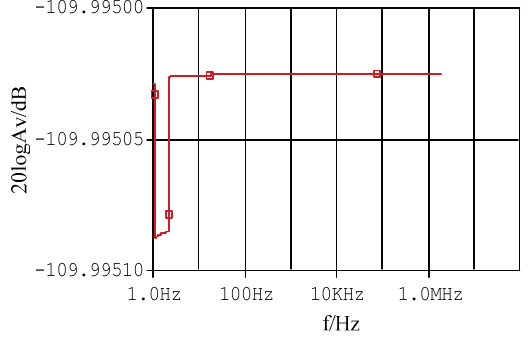
Figure 6. Bode plots of self-integrating D-dot